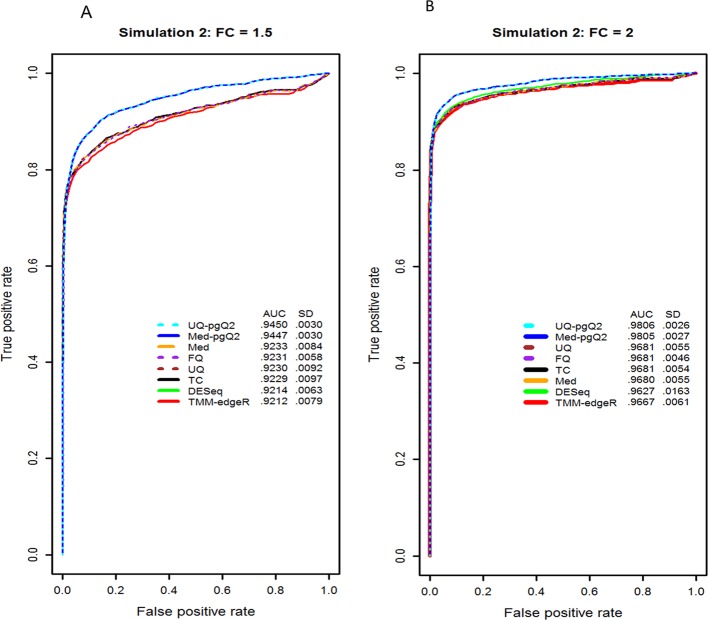
ROC curve and AUC values from the simulated data at a fold-change of 1.5 and 2.Illustrated are the ROC curves for detecting 1, 500 DEGs (750 up and 750 dow-regulated) using a fold change = 1.5 (A) and a fold change = 2 (B) with an unequal library size. Calculated AUC values are in the inset. The simulated data, containing a total of 15,000 genes in two conditions and 10 replicates per condition, was used for evaluating the performance of eight normalization methods. Our methods (UQ-pgQ2 and Med-pgQ2) are in cyan and blue, respectively.